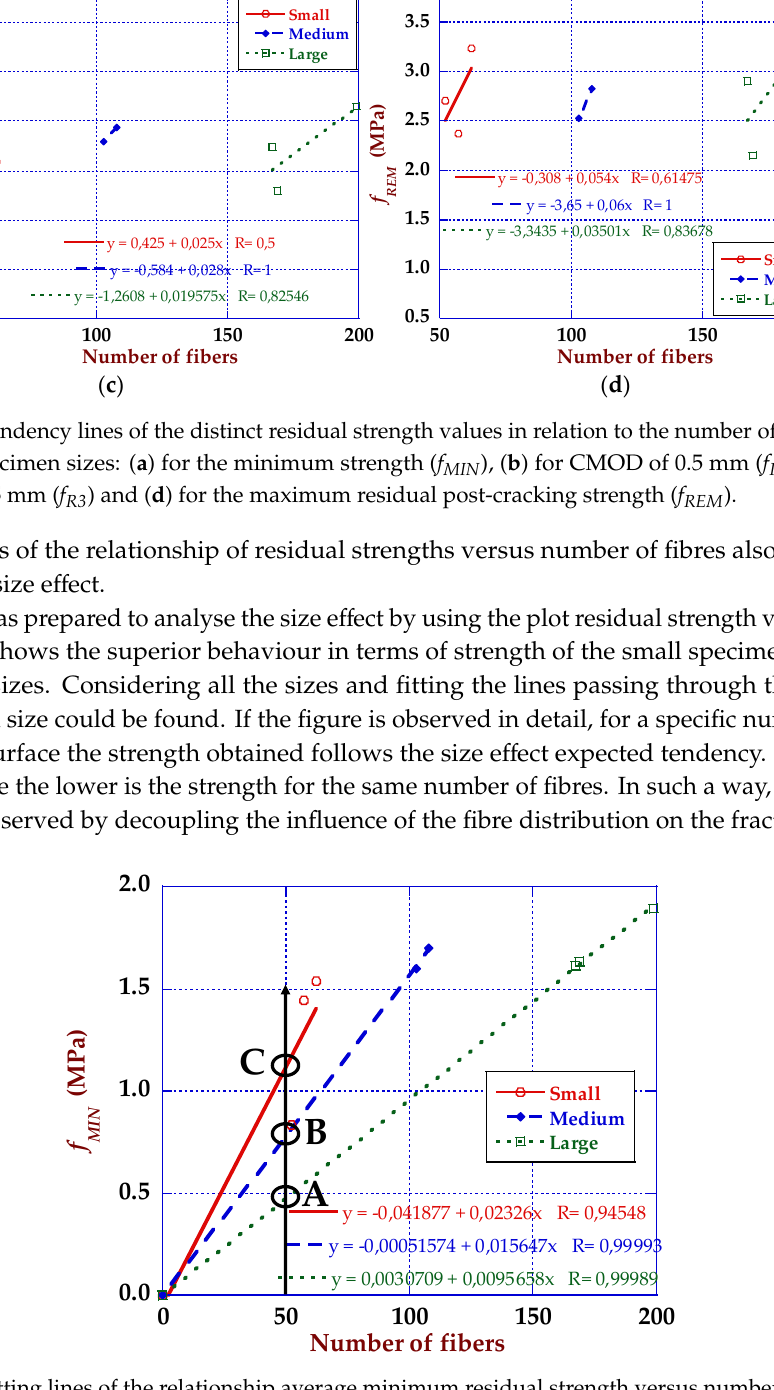
Figure 12. Fitting lines of the relationship average minimum residual strength versus number of fibres.